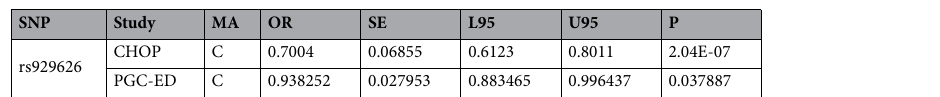
Table 1. Association results for the lead genotyped SNP. Abbreviations: MA, minor allele; OR, odds ratio; SE, standard error; L95, lower 95% confidence interval; U95, upper 95% confidence interval; P,